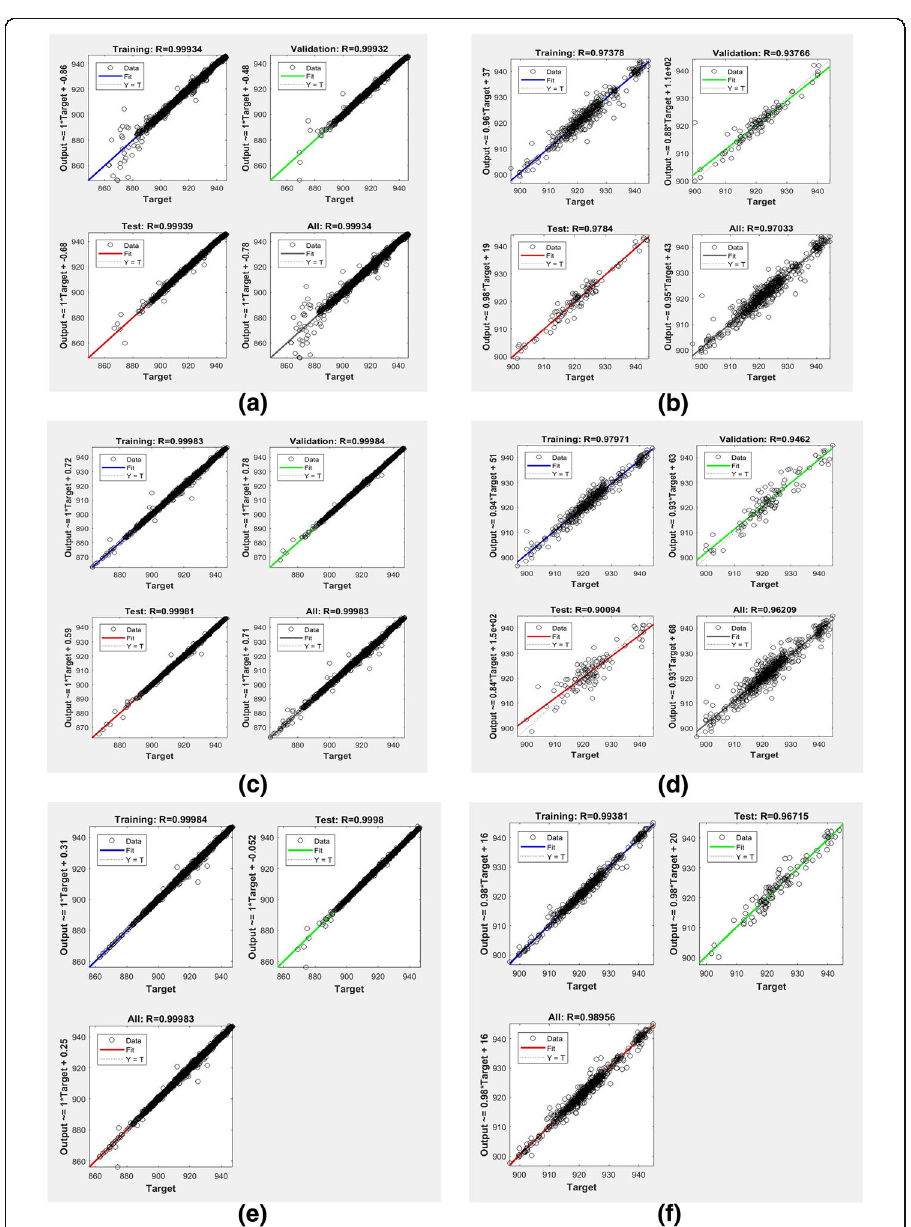
Fig. 4 Regression plots. ( a ) SCG on tick data: ( b ) SCG on 15-min data: ( c ) Levenberg-Marquardt on tick data: ( d ) Levenberg-Marquardt on 15-min data: ( e ) Bayesian Regularization on tick data: ( f ) Bayesian Regularization on 15-min data